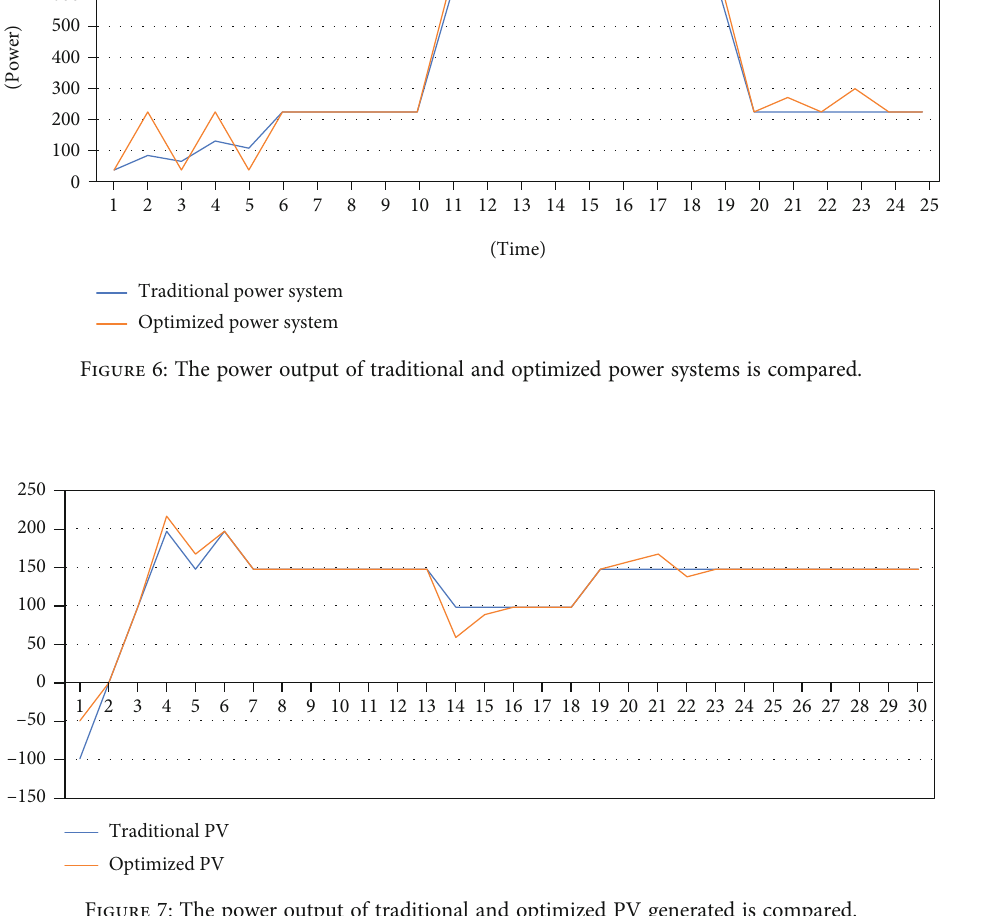
Figure 7: The power output of traditional and optimized PV generated is